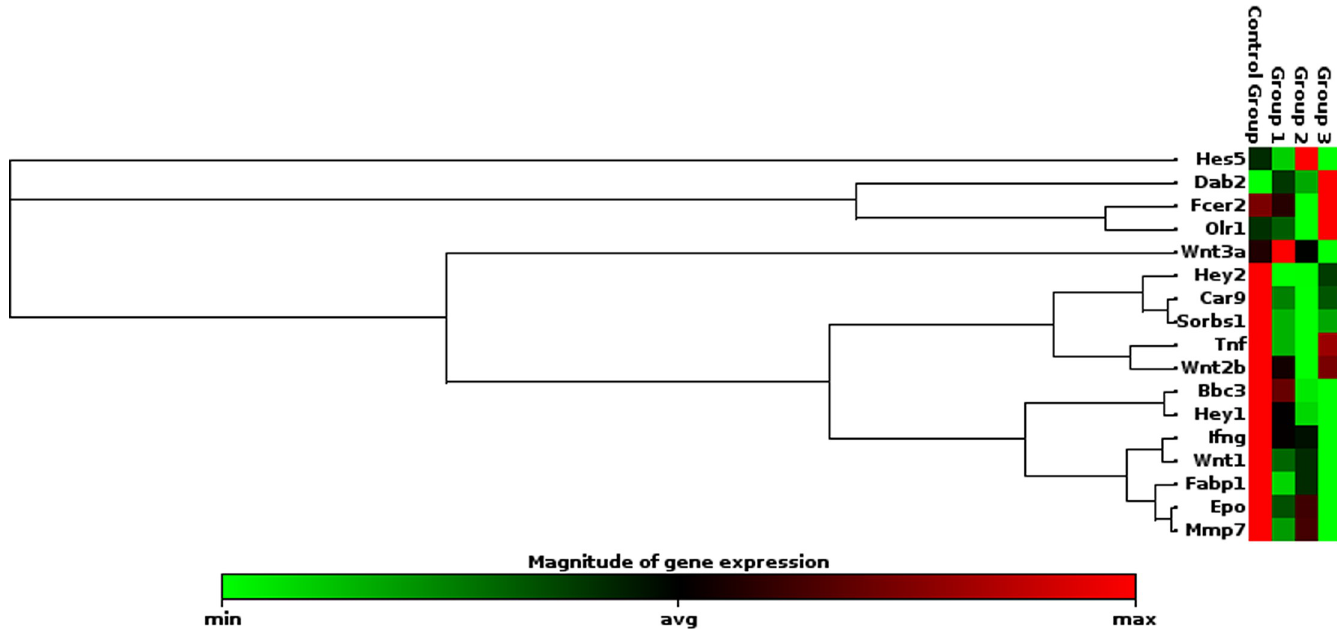
Fig 12. Clustergram of genes expressed significantly following 532 nm laser exposure at high irradiance of 0.50 W/cm 2 .